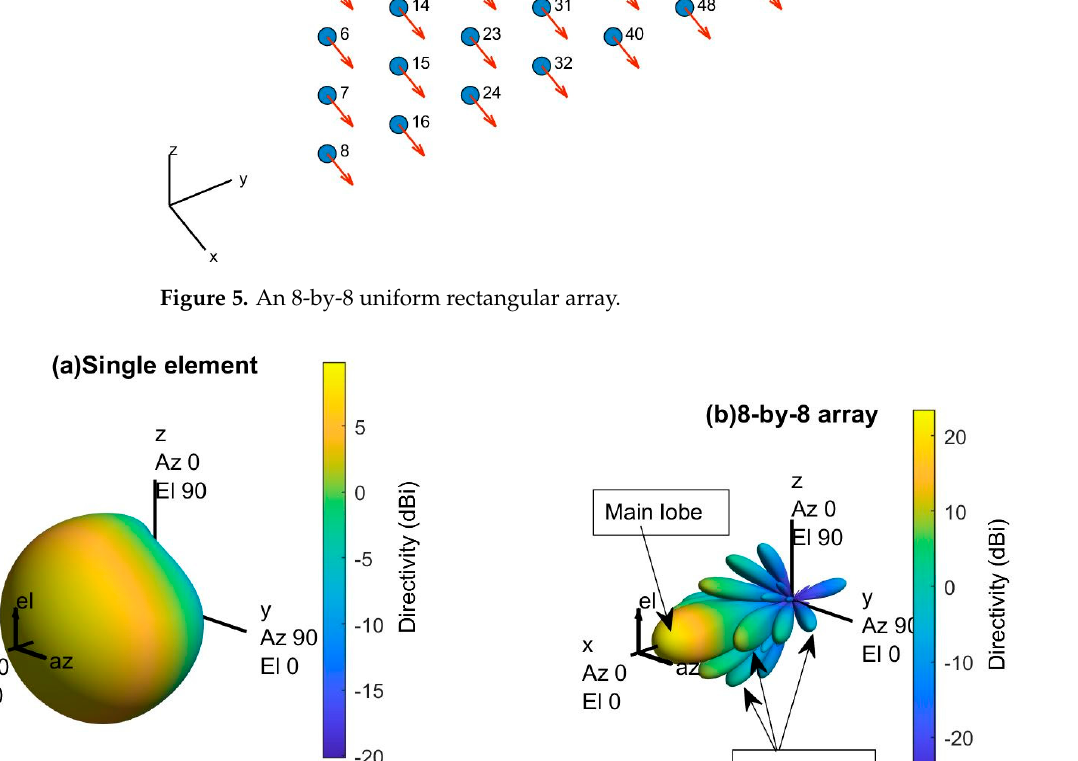
increases with the sizes of the array [19]. The 5G networks will use the larger antenna array